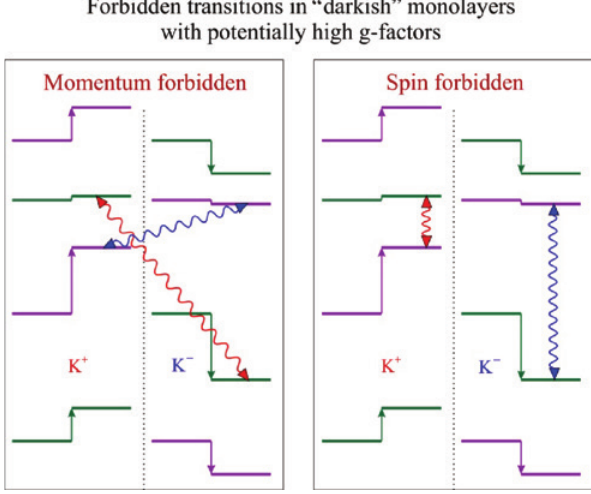
Figure 9: Pictorial representation of optically forbidden transitions in a “darkish” TMD monolayer. In the left panel, the inter-valley momentum forbidden recombina- tion is shown, which, according to the model discussed in the main text, gives a value of a g-factor equal to −10. In the right panel, a spin forbidden recombination from the lower energy conduction band is indicated, which within the proposed model implies a g-factor value of